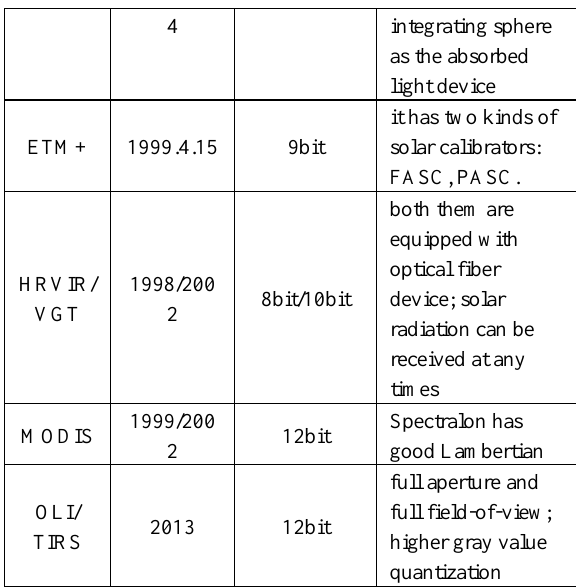
Table 2. Calibration characteristic of different